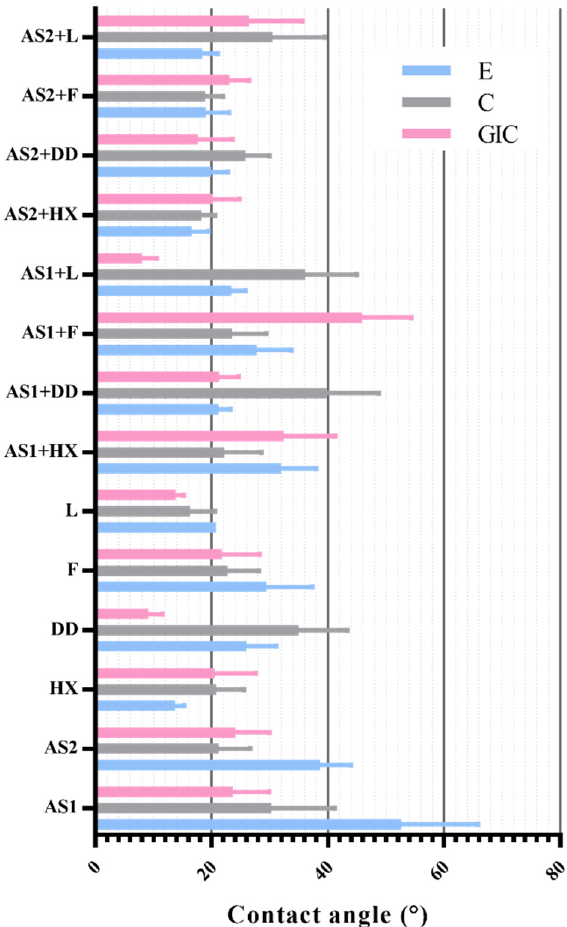
Figure 4. Droplets on the ( left ) enamel surface, ( middle ) glass-ionomer, and ( right ) composite ma- terial.